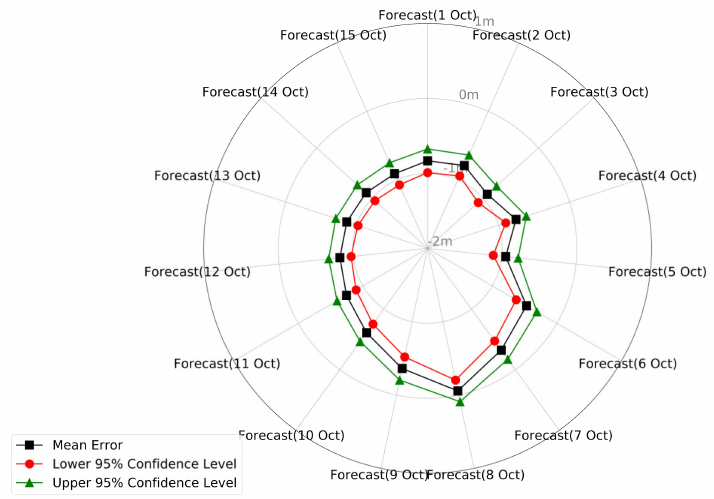
Figure 5. The mean error and the 95% confidence levels of the errors of the simulated peak water surface